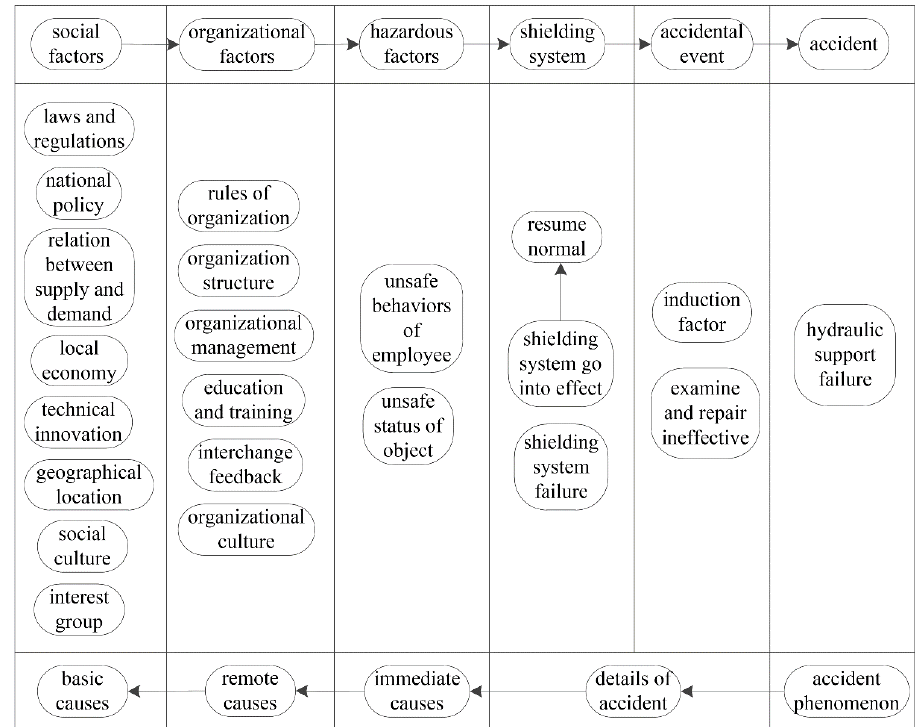
Figure 6. Synthetic theory model of hydraulic support failure.